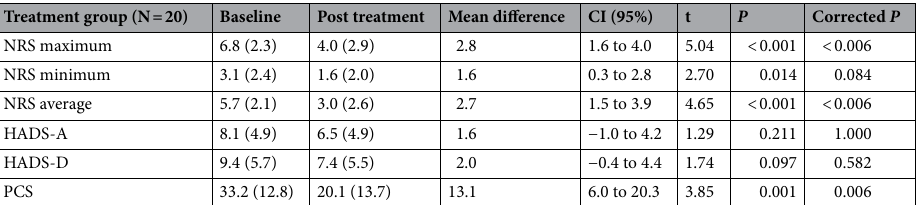
Table 3. Comparison of the degree of improvement in each evaluation scale before and after treatment. CI confidence interval, HADS-A/D Hospital Anxiety and Depression Scale-subscale for anxiety/depression, NRS numerical rating scales, PCS Pain Catastrophizing Scale. P values were corrected by multiplying with 6, the number of tests for multiple testing within the table, and expressed as corrected p (i.e., Bonferroni correction).